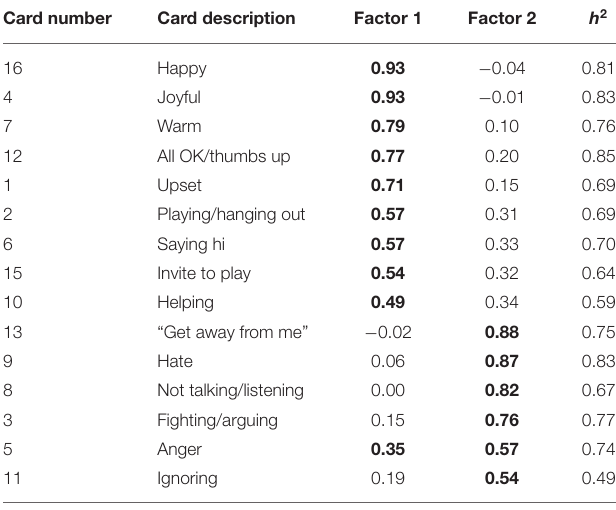
TABLE 2 | Factor loadings and communalities for two-factor solution of fifteen items for the Line Task (Study 1). Card number